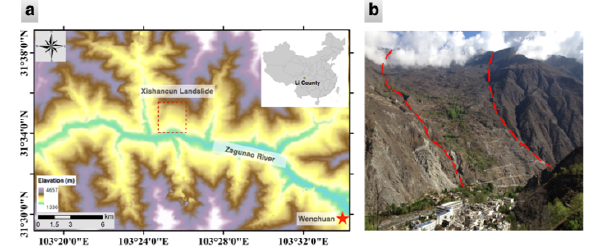
Figure 1. The overview of Xishancun Landslide